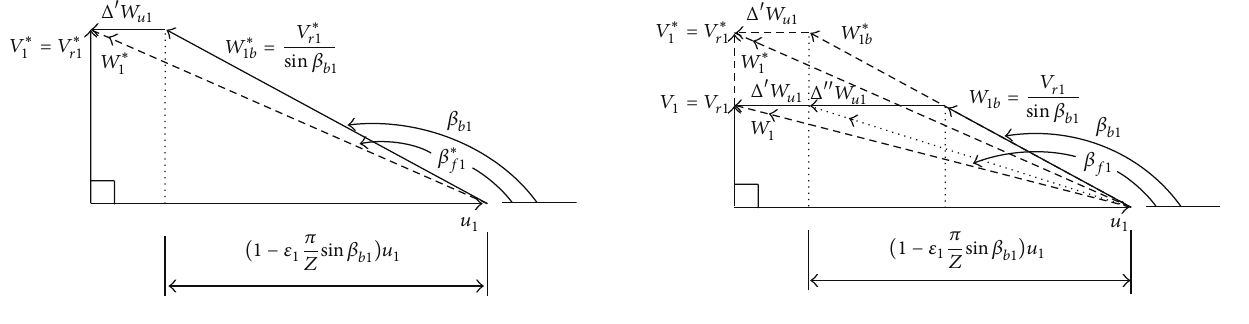
Figure 4: Velocity diagram at impeller inlet without shock. Figure 5: Velocity diagram at blade inlet with shock